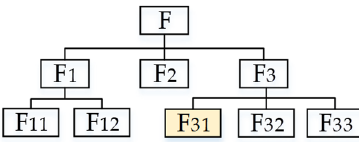
Figure 8. Function breakdown.